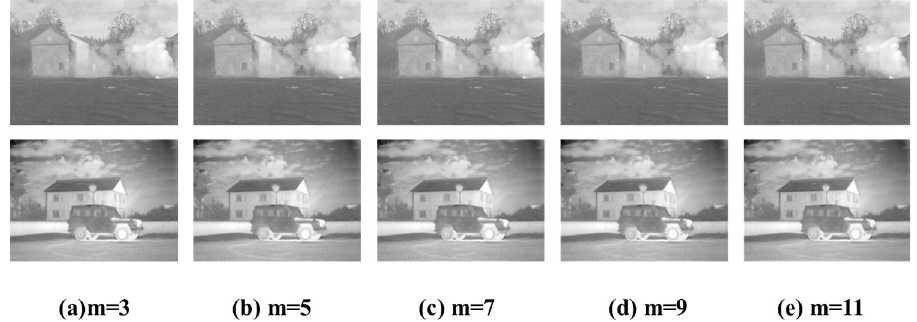
Fig 8. Fusion results according to mean filter window dimension. (a)m = 3, (b) m = 5, (c) m = 7, (d) m = 9, (e) m = 11.